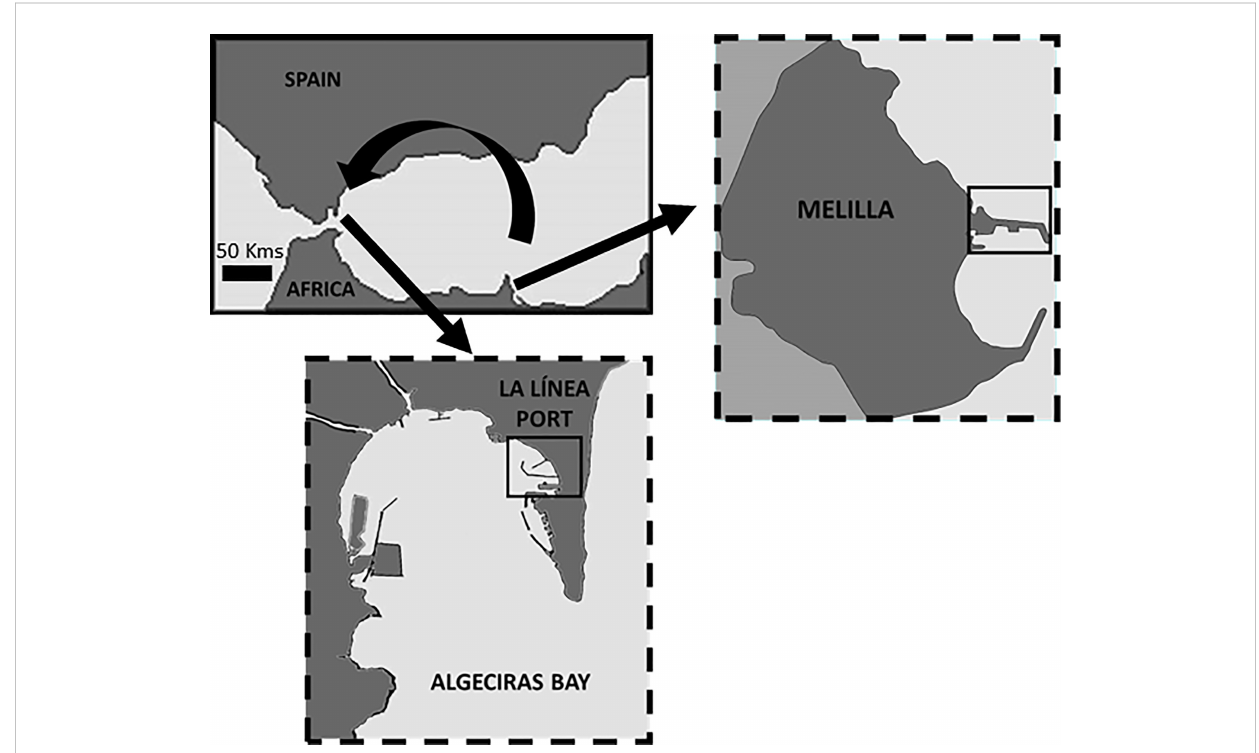
FIGURE 1 Map of the study area showing the donor and receptor sites located in Melilla and La L ı ́ nea ports,